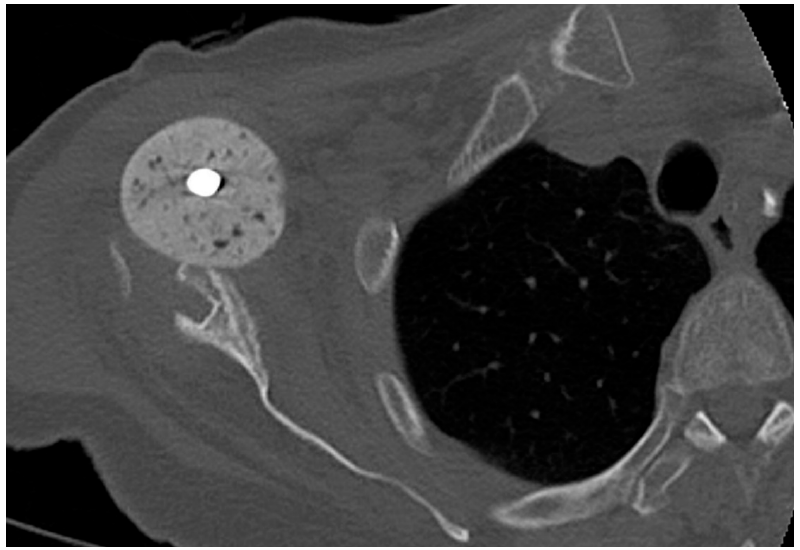
Figure 6. Axial plane of a computer tomography, right shoulder with anterior spacer dislocation and ventral glenoid erosion.